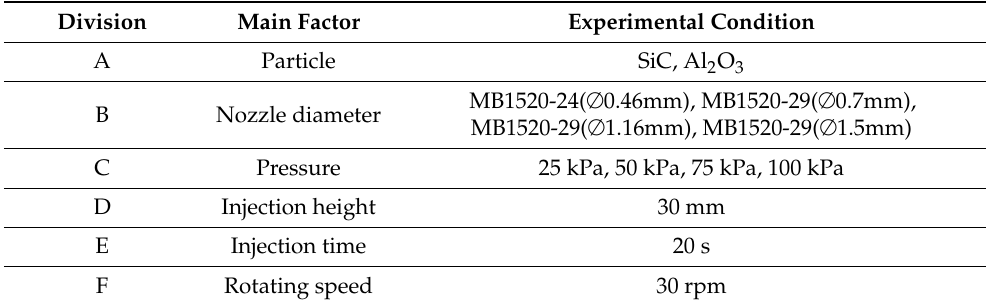
Table 1. The pre-tested results for main factors and